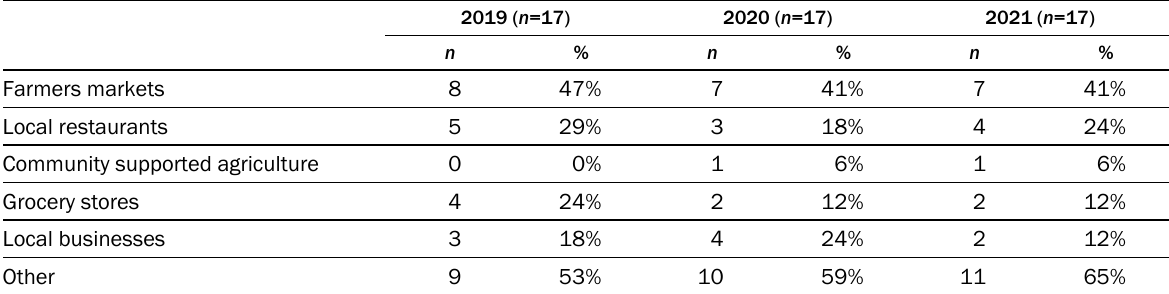
Table 6. Responses to the Question: “ Where did you sell your products for the past three years [2019 – 2021]? Choose all that apply